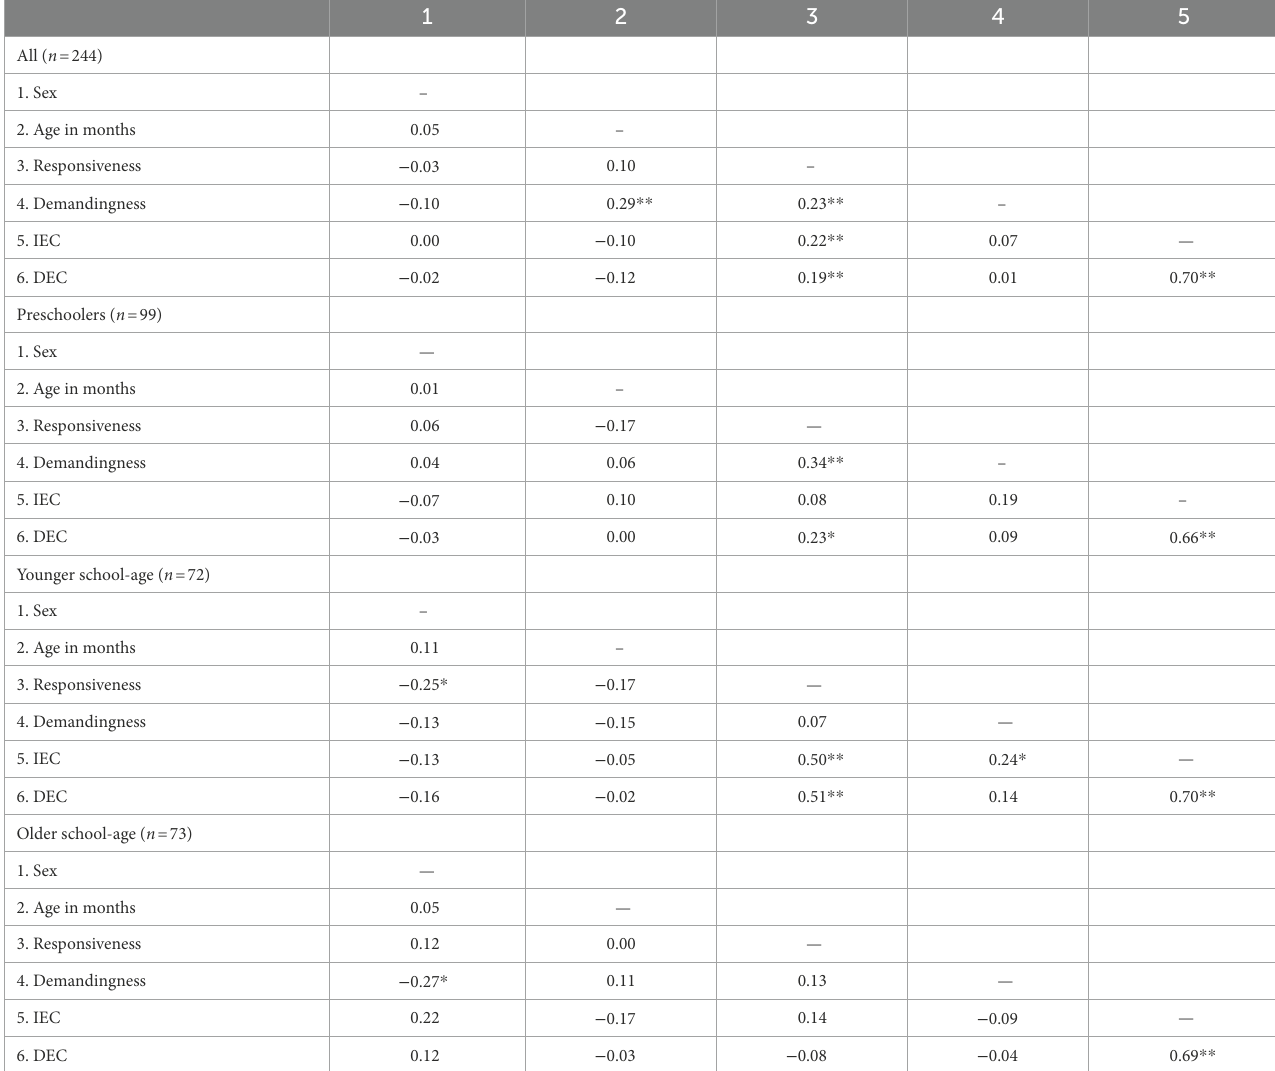
TABLE 2 Spearman’s rank order correlations between